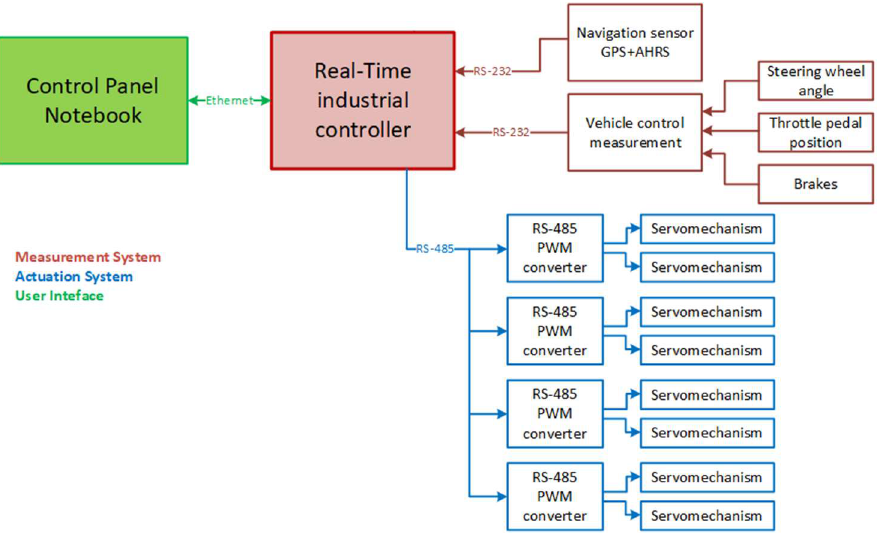
Figure 30. Structure of the data acquisition and control system.